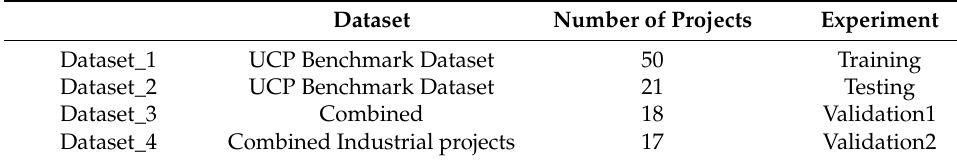
Table 3. Information on used datasets (UCP).